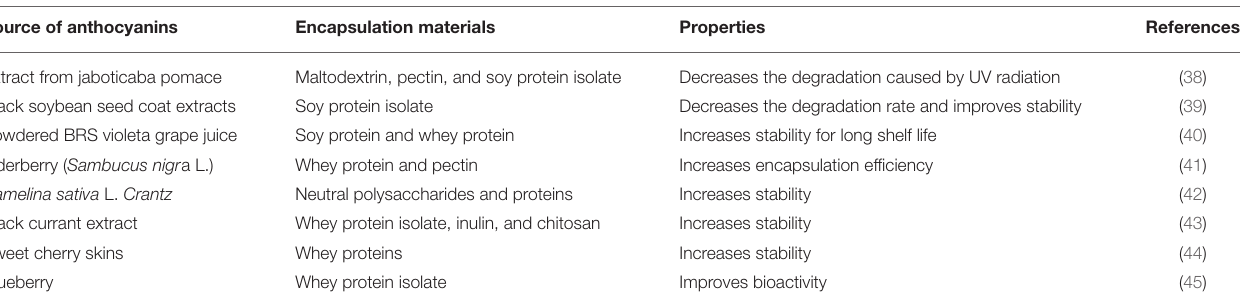
TABLE 1 | Properties of encapsulation materials for